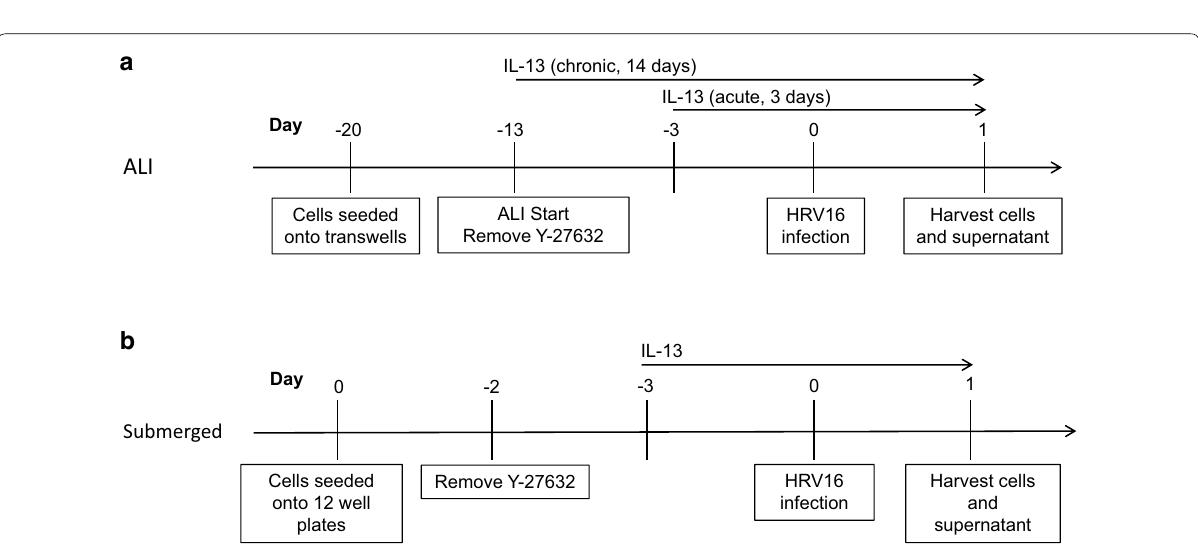
Fig. 1 Timeline for ALI cultures ( a ) and submerged cultures ( b ) of paired human primary bronchial and nasal epithelial cells